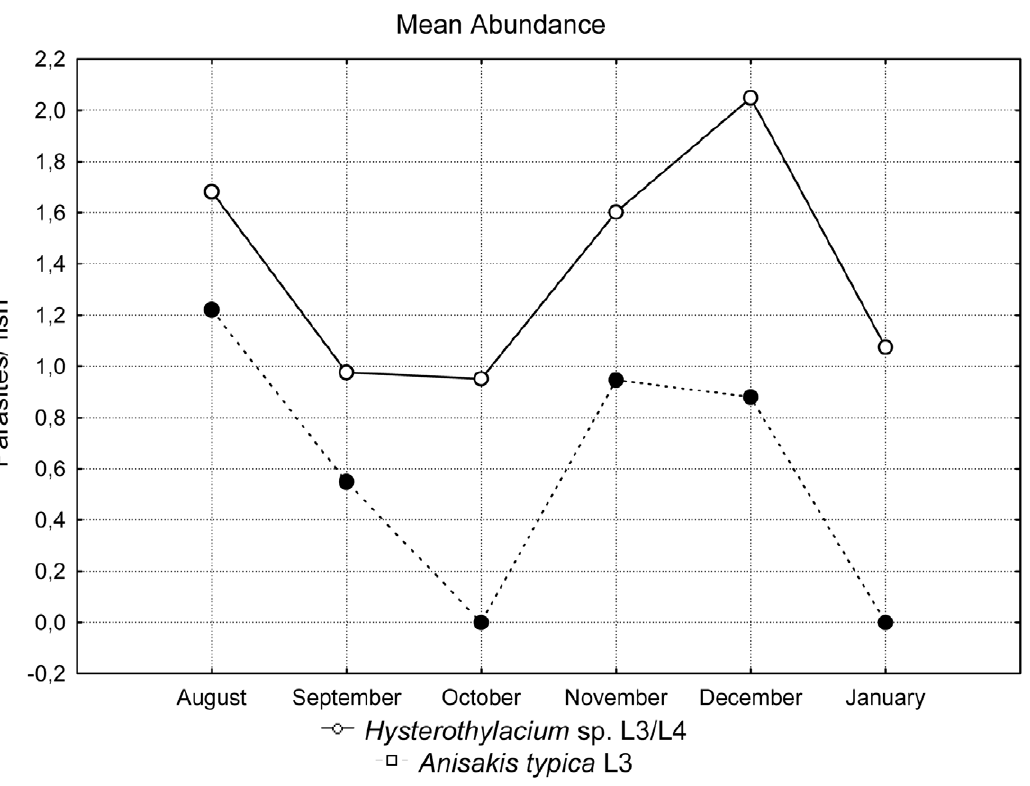
Figure 10. Ecological data of Anisakistypica and Hysterothylacium sp.: mean abundance (no. of parasites/fish) transformed using the fourth root.